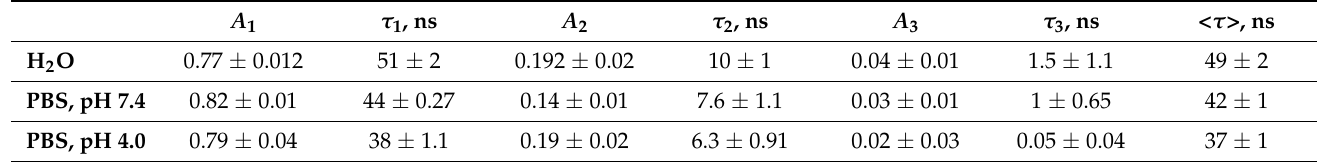
Table 1. Three-exponential fit parameters of the observed PL lifetime of InP-QDs in H 2 O and PBS solutions after 24 h of